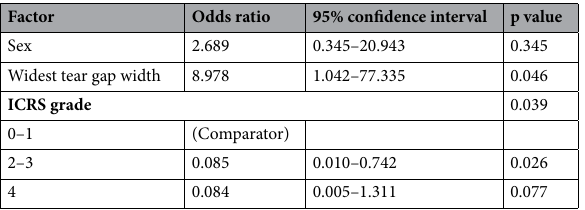
Table 4. Multiple logistic regression analysis results of factors to the success of arthroscopic surgery. ICRS International Cartilage Repair